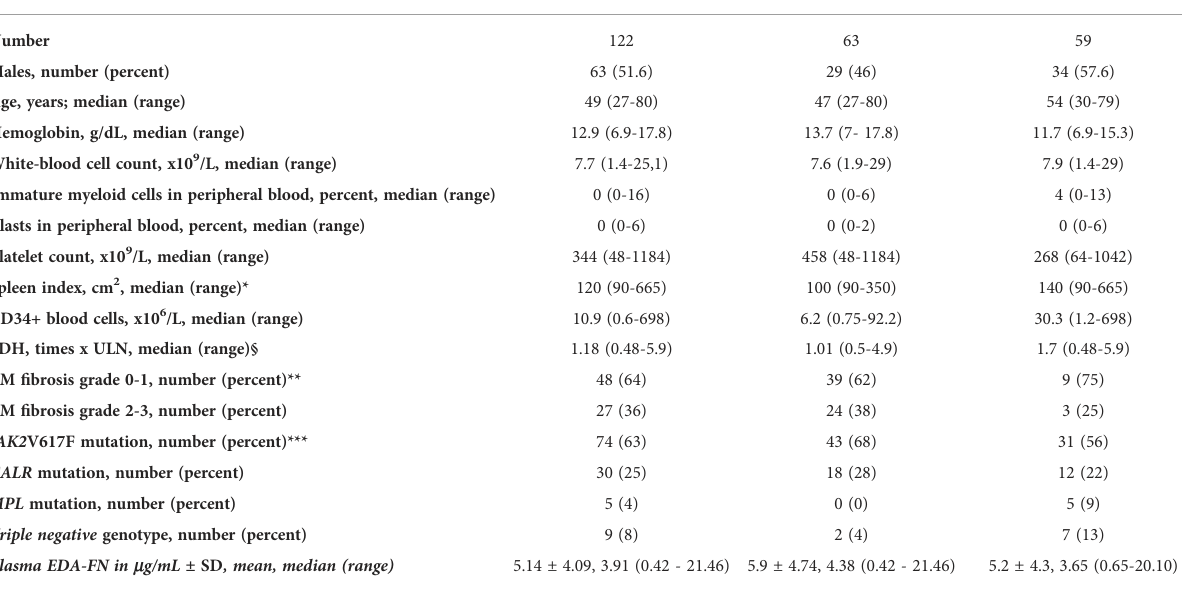
TABLE 1 Demographic, clinical features and plasma EDA-FN concentrations of patients with primary myelo fi brosis (PMF) at the time of plasma samples collection used for EDA-FN quanti fi cation. Total population Patients at diagnosis Patients after diagnosis Number 122 63 59 Males, number (percent)